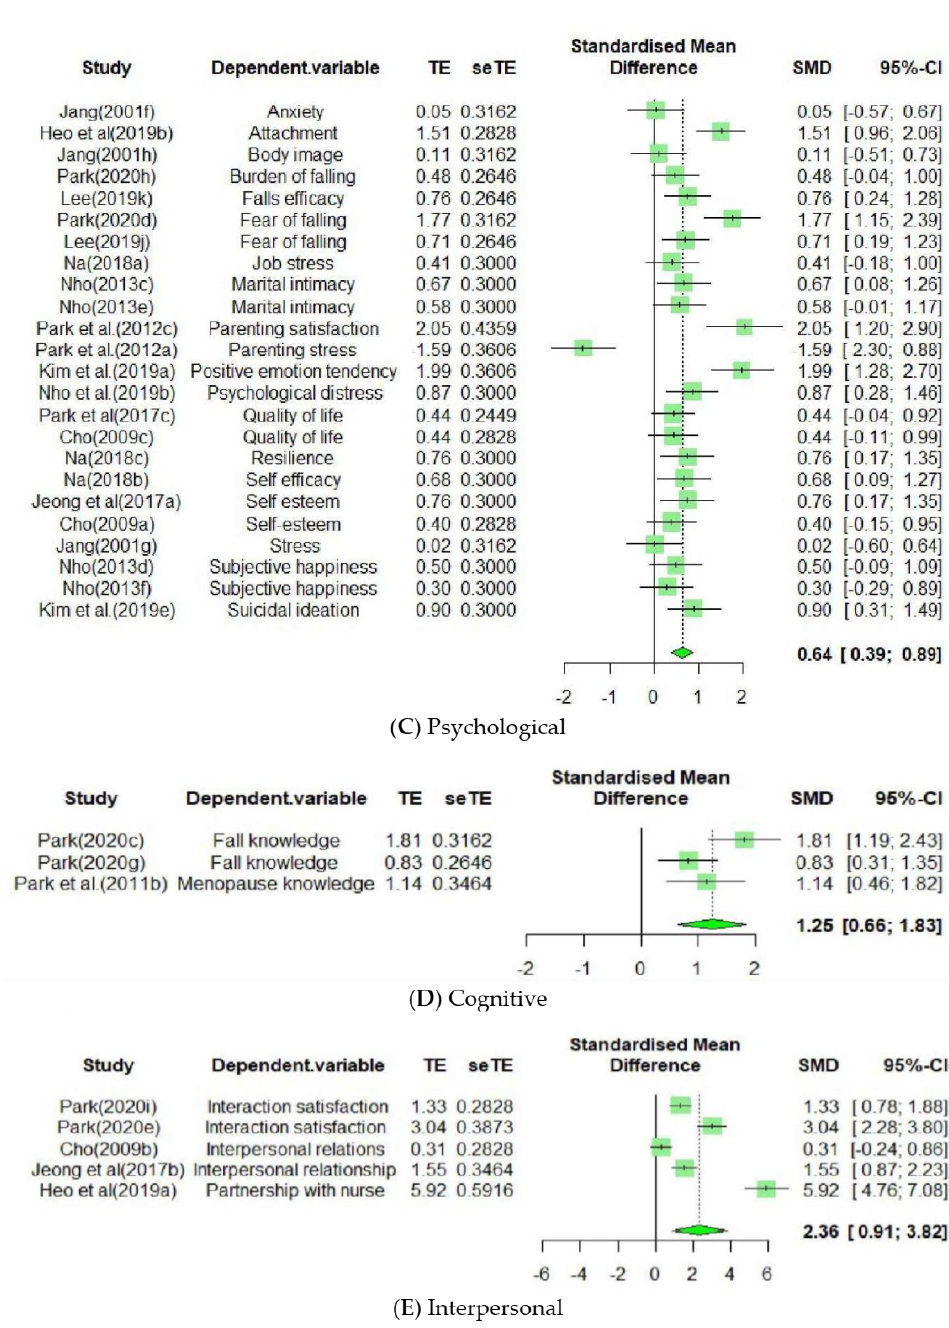
Figure 5. Forest plot of the effect of dependent variables: ( A ) Indicators of physical health, ( B ) Health behavior, ( C ) Psychological, ( D ) Cognitive, ( E )